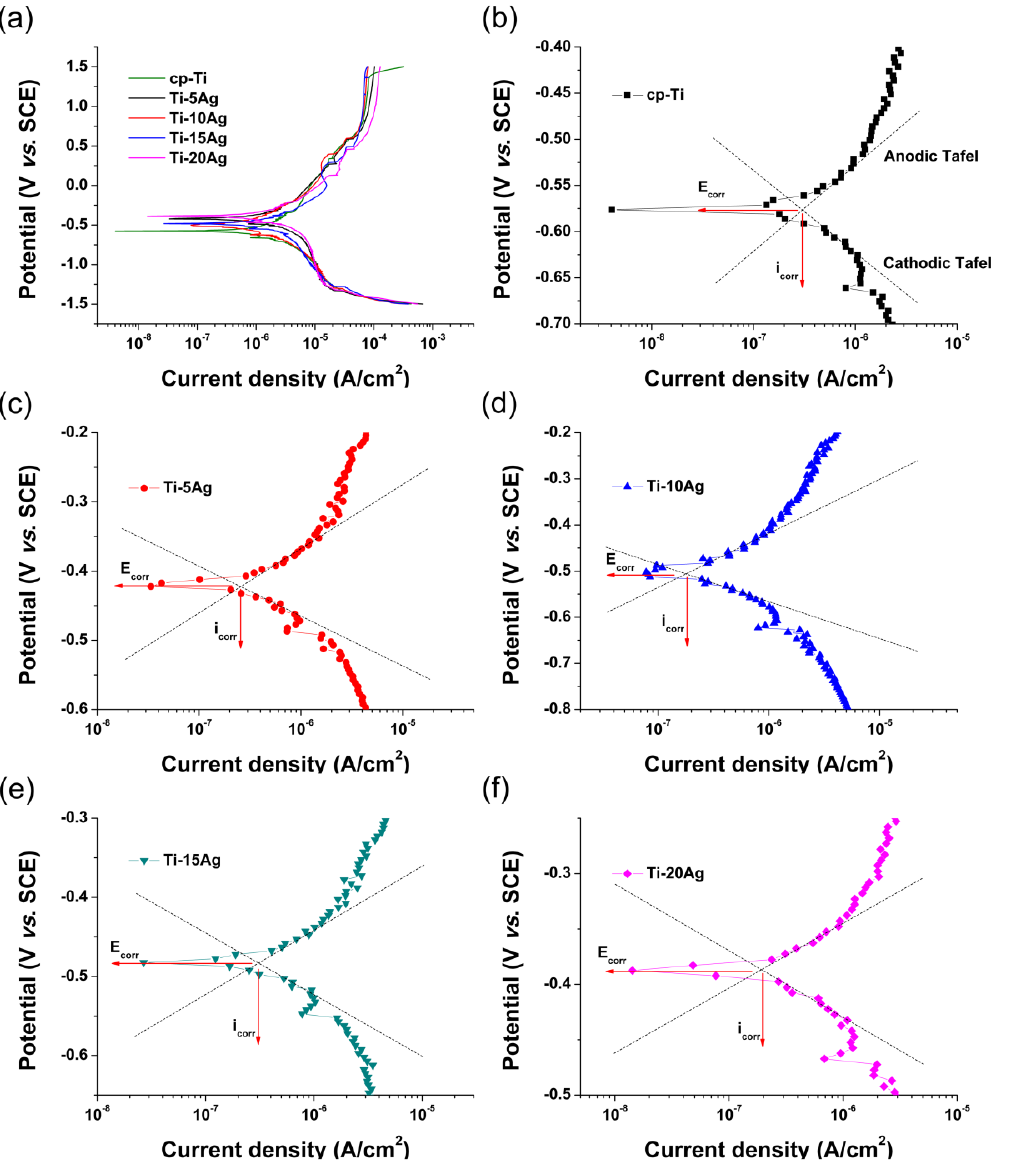
Figure 8. Representative potentiodynamic polarization curves for the cp-Ti and Ti– x Ag alloys. SCE, saturated calomel